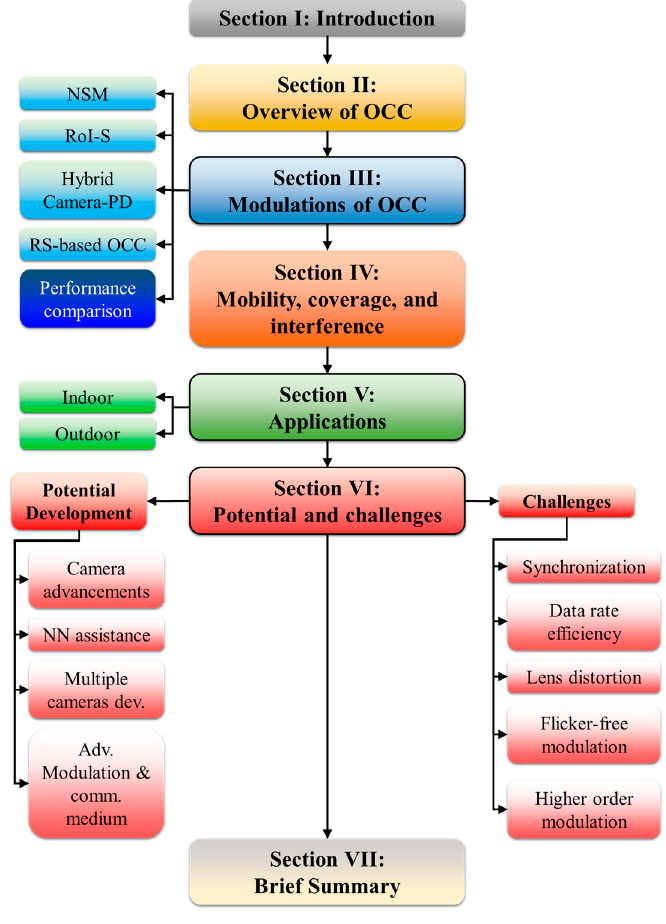
Figure 3. The paper organization.